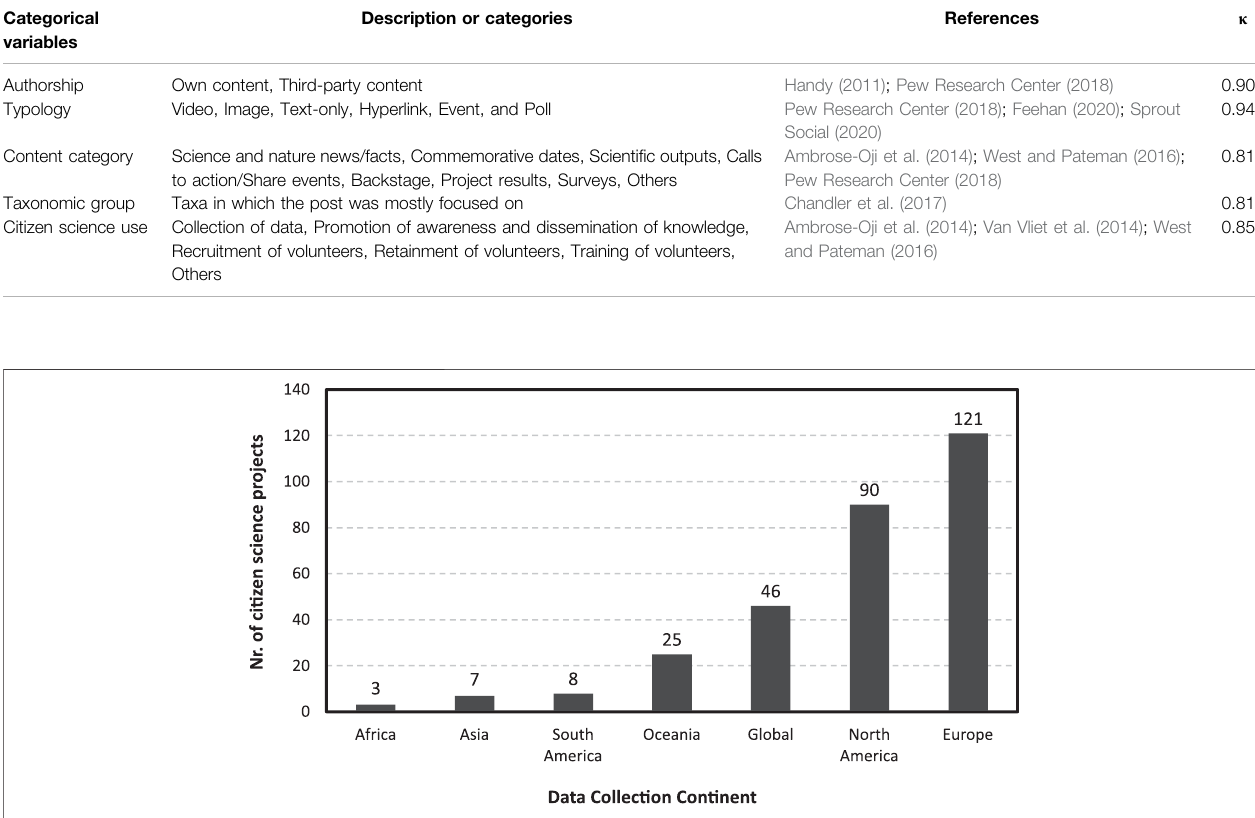
Frontiers in Environmental Science |